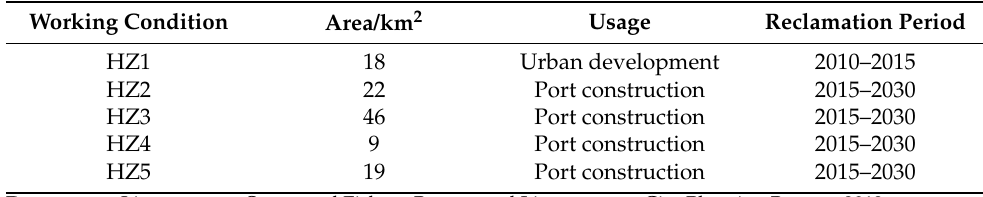
Figure 2. The geographic location of reclamation projects in Haizhou Bay (HZ1-HZ5 represent five projects). Table 1. Description of reclamation